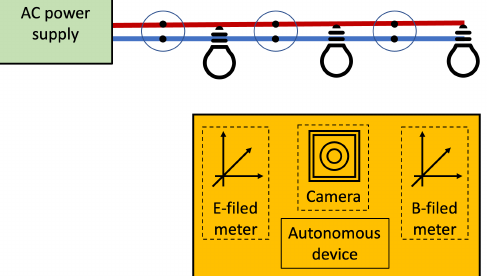
Figure 3. Sensors employed for self-positioning by some Infra-less Target-based